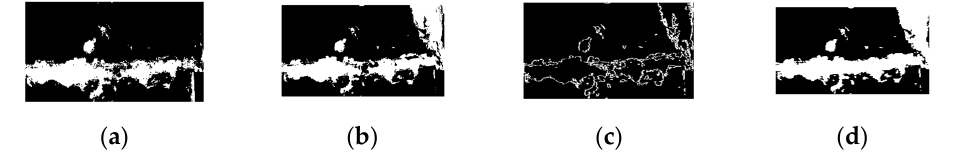
Figure 10. Influence of threshold value on the performance metric elements.